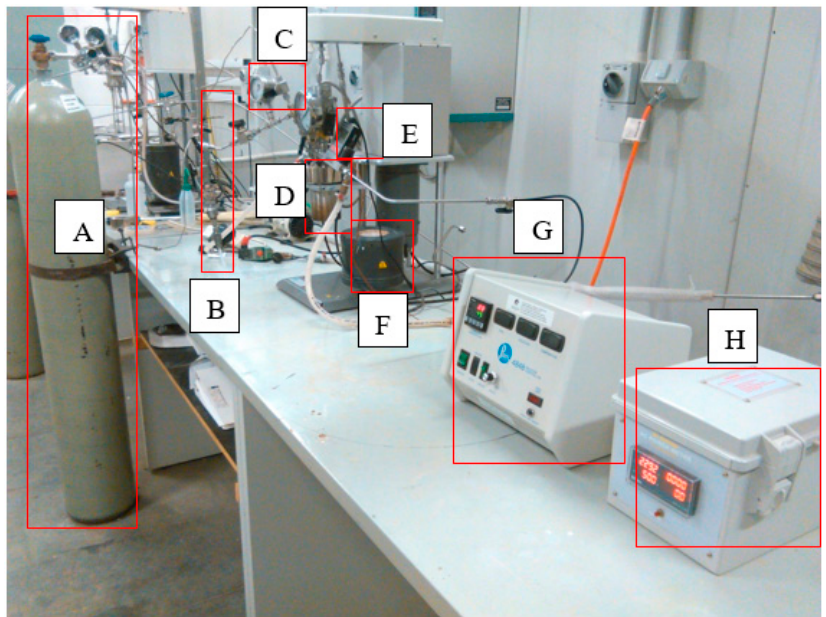
Figure 4. Photo of the carbonic acid dissolution experimental set-up closed (back pressure regulator (BPR)) system, ( A ): Carbon dioxide gas cylinder, ( B ): Sampler to sample slurry, ( C ): Low pressure gauge, ( D ): Reactor vessel, ( E ): Back pressure regulator, ( F ): Electric heater for heating the slurry during the reaction, ( G ): Temperature and revolution per minute (RPM) controller, ( H ): Power meter.